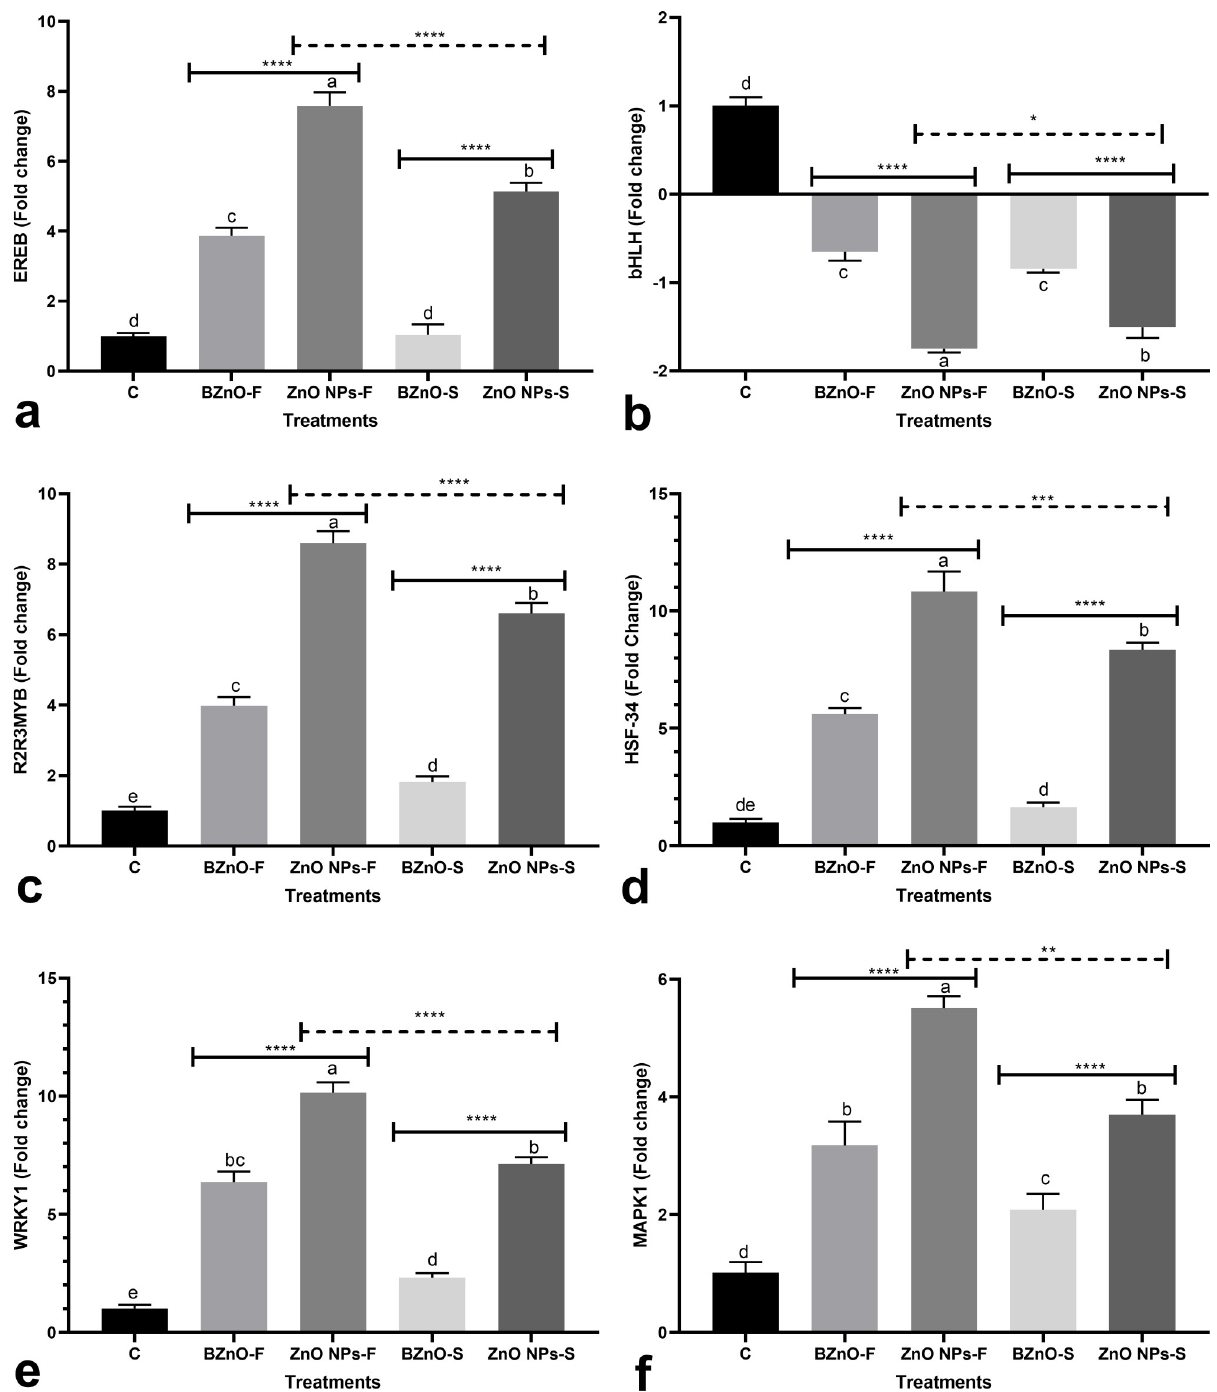
Fig 1. The effects of BZnO or ZnONP in two application methods (foliar and supplementation of nutrient solution) on the transcription of several genes, including EREB [a], bHLH [b], R2R3MYB [c], HSF -34 [d], WRKY1 [e], and MAPK1 [f]; The treatment groups: C: Control; BZnO-F: Foliar application of BZnO; ZnO NPs-F: Foliar application of ZnO NPs; BZnO-S: Supplementation of nutrient solution with BZnO; ZnO NPs-S: Supplementation of nutrient solution with ZnO NPs; Different letters on the columns refer to statistically significant differences according to Tukey’s multiple comparisons test. A comparison between the two BZnO and ZnO NPs groups at the same method is presented by placing an asterisk [ � ] on the line, while asterisks [ � ] on the dashed lines define the comparison between two ZnO NPs-F and ZnO NPs-S groups. ns: Non-significant; � : 0.01 < p � 0.05; �� : 0.001 < p � 0.01; ��� : 0.0001 < p � 0.001; ���� : p � 0.0001.